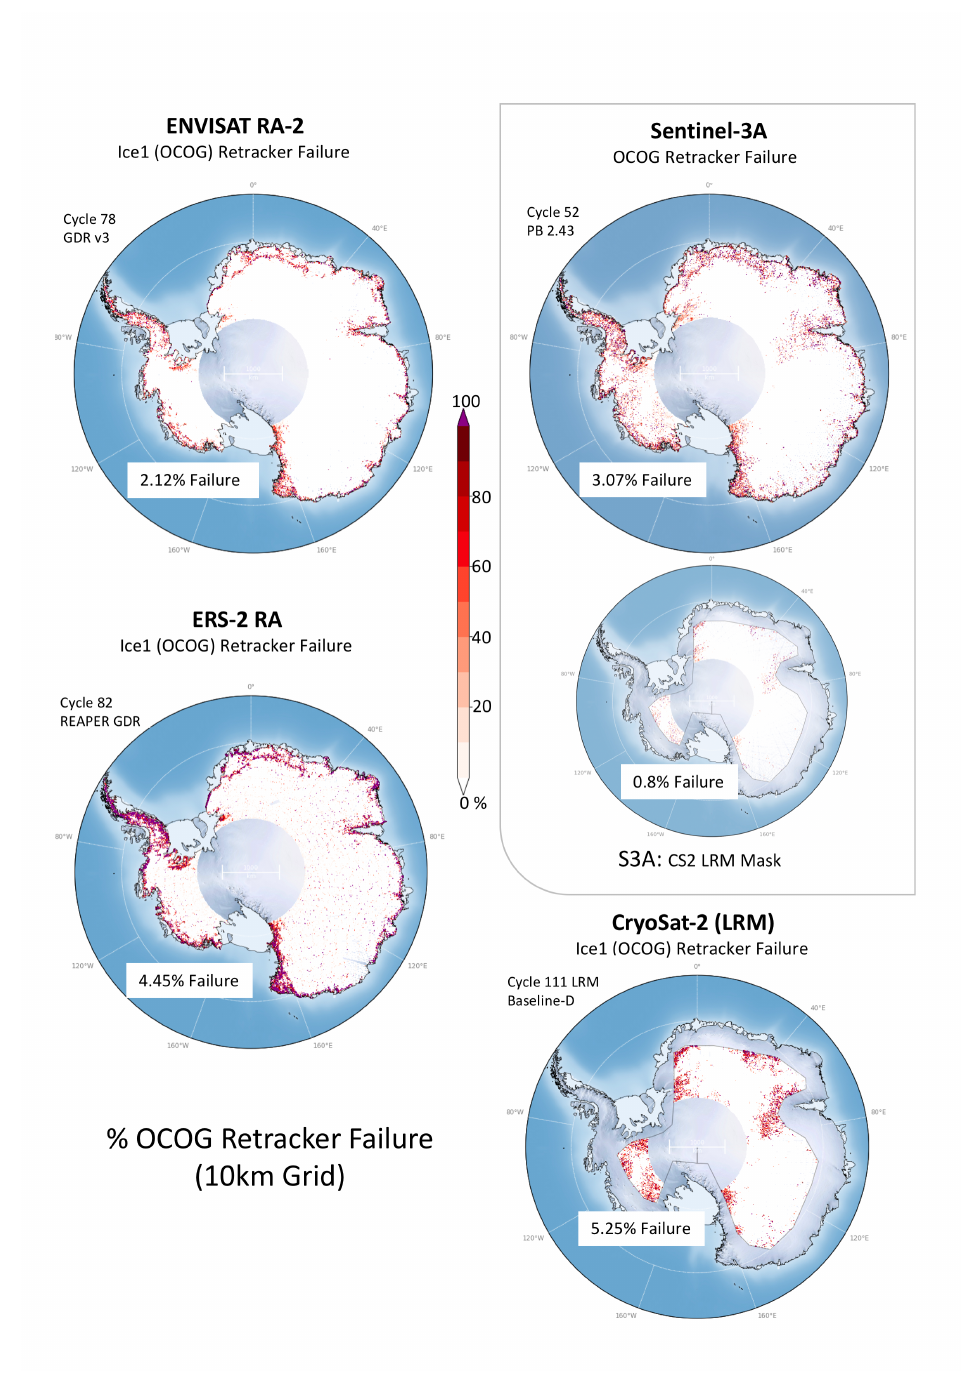
Figure 32. Comparison of gridded percentage failure rates for OCOG retracker for S3A SAR, Envisat, ERS-2 and CryoSat-2 (LRM mode) over